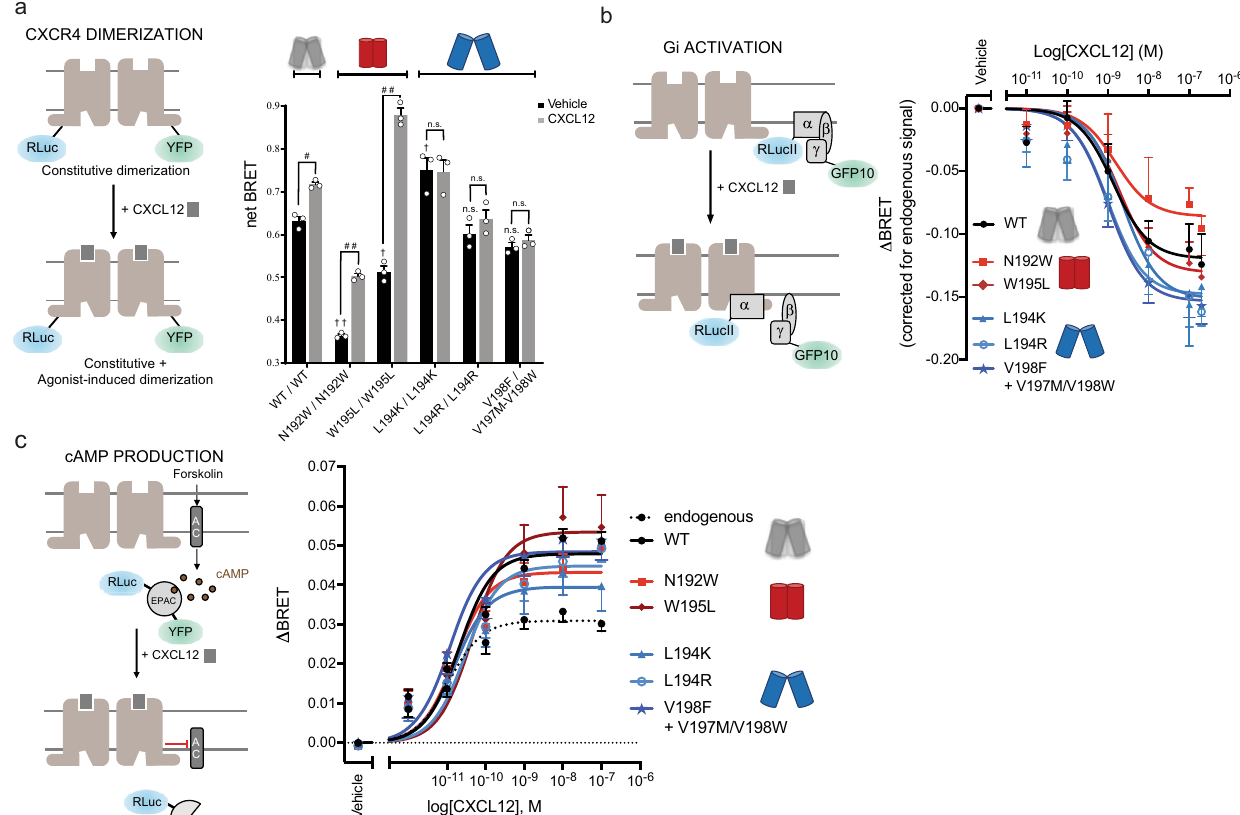
Fig.3|CXCR4associationandGiactivation.a (Left)Schematicrepresentationof the CXCR4 dimerization BRET-based assay. (Right) CXCR4 association was mea- sured by BRET before (black)and after agonist stimulation (gray) in HEK293T cells transfected with CXCR4-RLuc and its counterpart CXCR4-YFP, WT, or mutant as indicated. BRET 480-YFP was measured after the addition of coel-h (10min) and CXCL12 (15min). Data shown represent the mean±SEM of three independent experimentsandareexpressedasnetBRET(calculatedbysubtractingbackground luminescence). Statistical signi fi cance was assessed using a two-way ANOVA fol- lowed by a Š ídák ’ s multiple comparisons test: # p =0.007, ## p <0.0001, n.s. not signi fi cant p >0.05 are used to compare BRET values between basal to CXCL12- treated conditions and † p =0.0004, †† p <0.0001 are used to compare basal BRET values between the mutants. b (Left) Schematic representation of the BRET-based ligand-induced Gi activation assay. (Right) CXCL12-promoted Gi activation